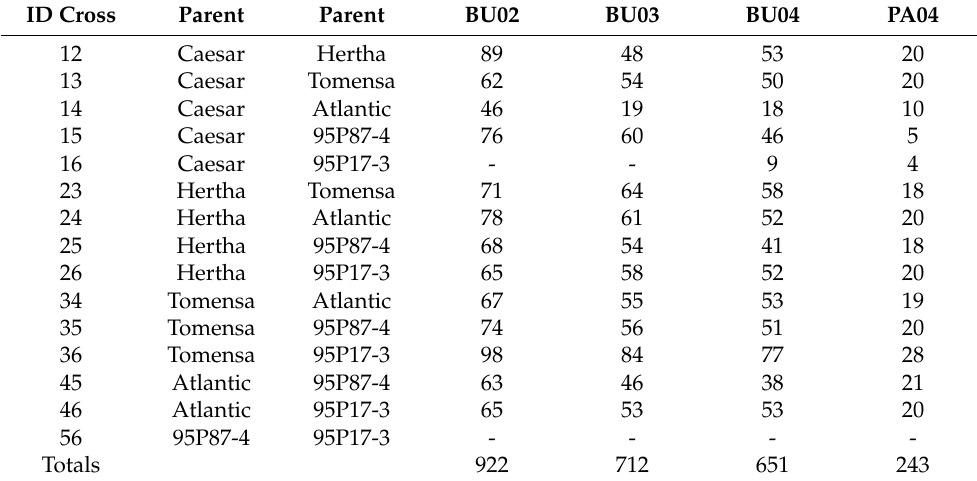
Table 3. Number of individuals collected in each